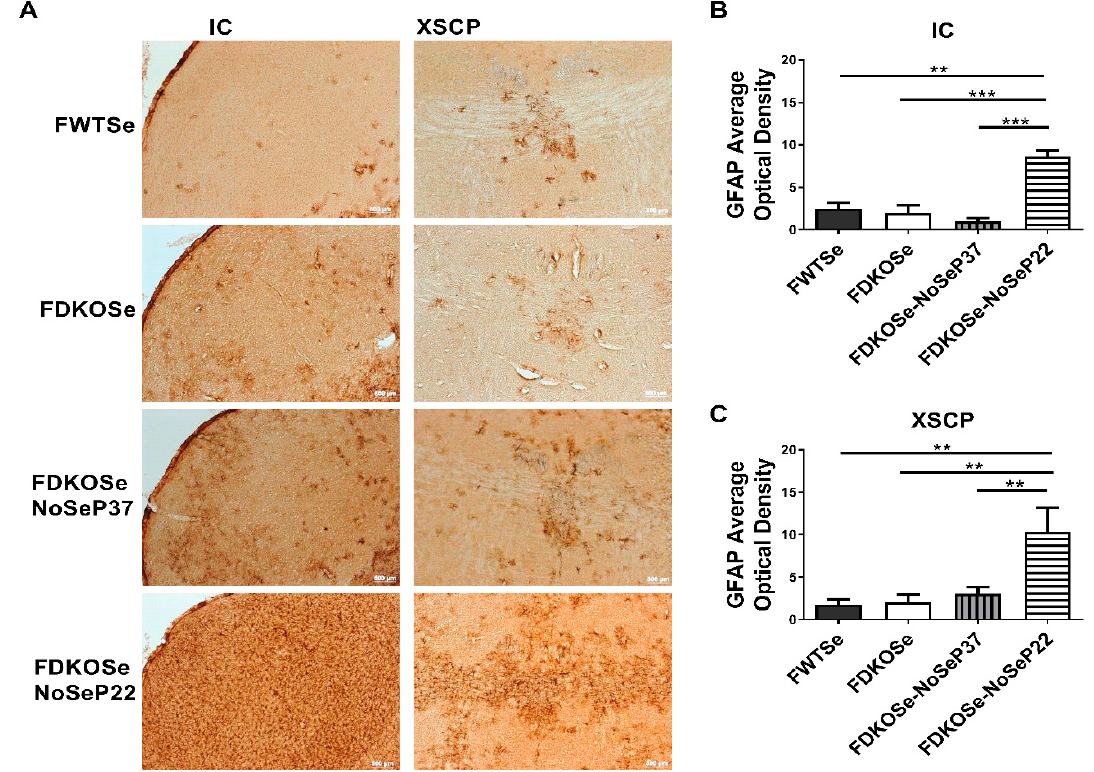
Figure 3. Effect of SeH 2 O (supplemental Se water) withdrawal age on glial fibrillary acidic protein (GFAP) immunoreactivity in female double knockout mice supplemented with Se (FDKOSe). ( A ) Representative images of inferior colliculus (IC) and the decussation of the superior cerebellar peduncle (XSCP) of female wild-type mice supplemented with Se (FWTSe), FDKOSe, FDKOSe-NoSeP37 (supplemental Se removed at P37), and FDKOSe-NoSeP22 GFAP mice at 10 weeks of age. Quantification of GFAP immunoreactivity in ( B ) IC and ( C ) XSCP. (One-way ANOVA IC p = 0.0003, XSCP p = 0.0151; Bonferroni’s multiple comparisons test: ** p < 0.005, *** p < 0.0005; n = 3 all groups). All values reported as mean ± SEM.